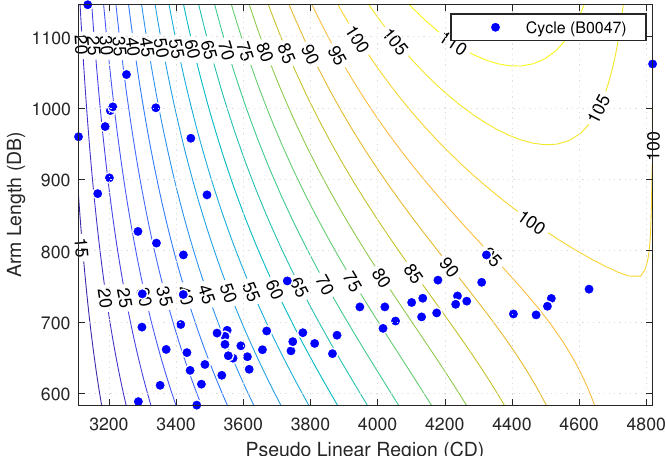
Figure 11. Contour plot showing the effect of cycle number on Arm Length and Pseudo Linear Region at 277.15